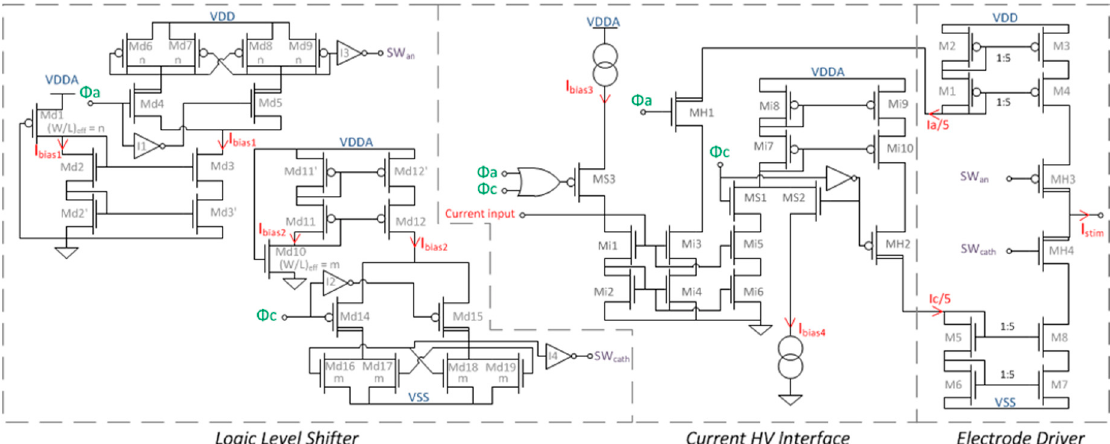
Figure 5. Schematic of the ESC circuit. From right to left, the ESC is composed of the electrode driver delivering the stimulation current to the electrode, an LV to HV interface block and a purely logic block combining the anodic and cathodic control signals. SWan and SWcath are internal signals; I bias1 , I bias2 , I bias3 , I bias4 are internal biasing currents. Ic and Ia are current sources; switches are controlled by Φ c and Φ a.